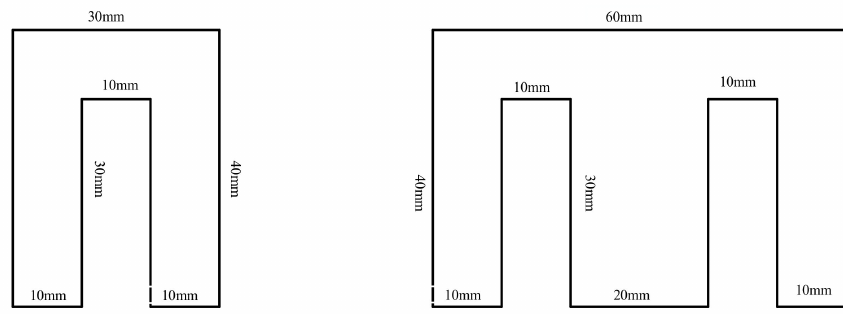
Figure 3. Dimension of magnetic steel lamination shape U and